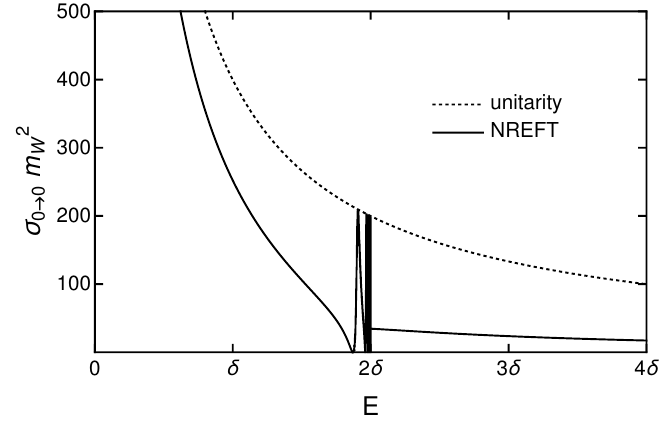
Figure 7 . Neutral-wino elastic cross section (cid:27) 0 ! 0 ( E ) at the unitarity mass M (cid:3) = 2 : 39 TeV as a function of the energy E . The S-wave unitarity bound is shown as a dotted